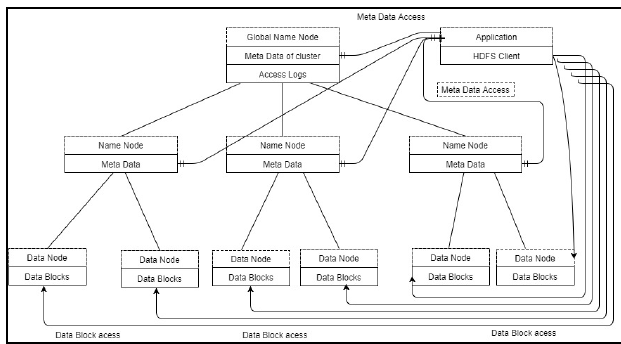
Fig. 4: Hierarchical Hadoop Distributed File